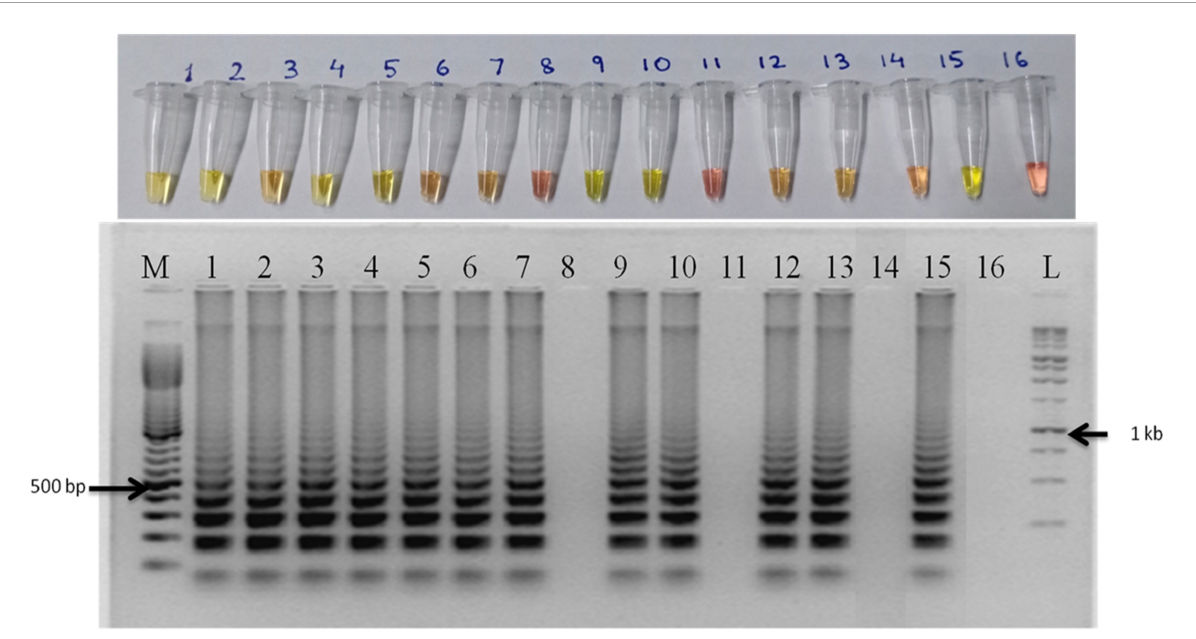
FIGURE5 M: 100 bp (Promega); 1: artificial inoculation with S. oryzae NAIMCC-F-01631; 2: artificial inoculation with S. oryzae NAIMCC-F-01634; 3: Pusa Basmati 1121; 4: RNR 2415; 5: Rajendra sweta; 6: Swarna MTU 7024; 7: Kalanamak BK-102; 8: TKM 13; 9: Kalanamak KN 3; 10: BPT 5204; 11: Saryu 52; 12: CO- 51; 13: Kalanamak 101; 14: Swarna sub 1; 15: Rajendra kasturi; and 16: No template